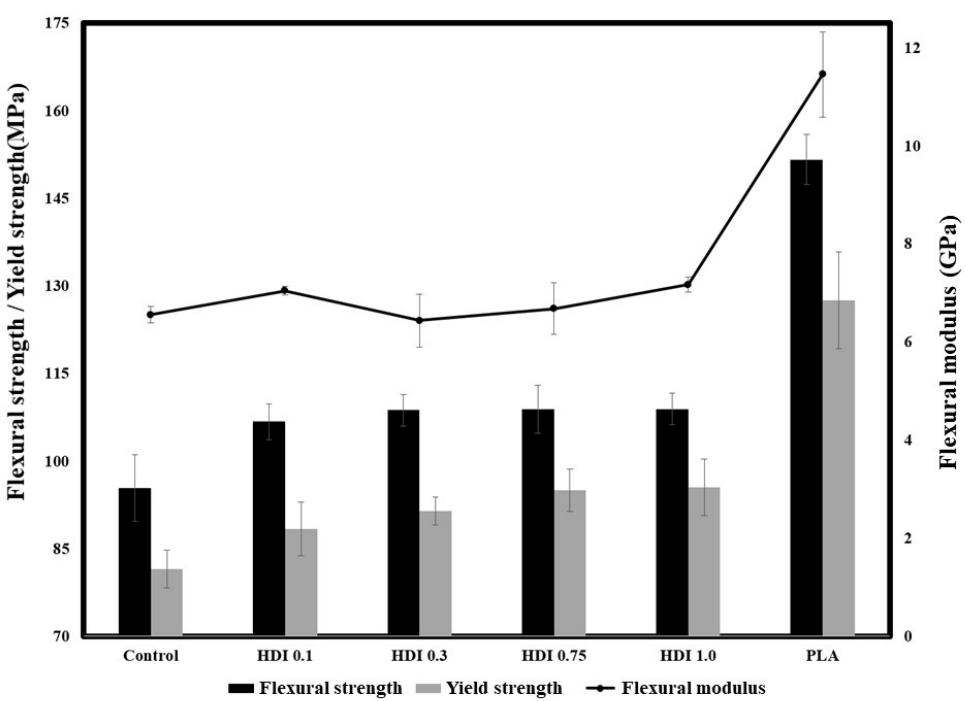
Figure 5. Three-point flexural strengths and moduli of neat PLA, control, and blend specimens prepared with various HDI contents.